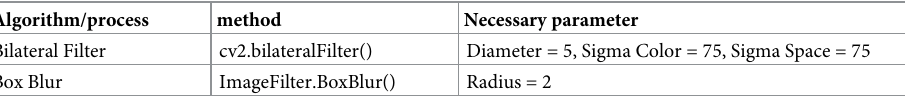
Table 6. Selected parameter for down-scaling